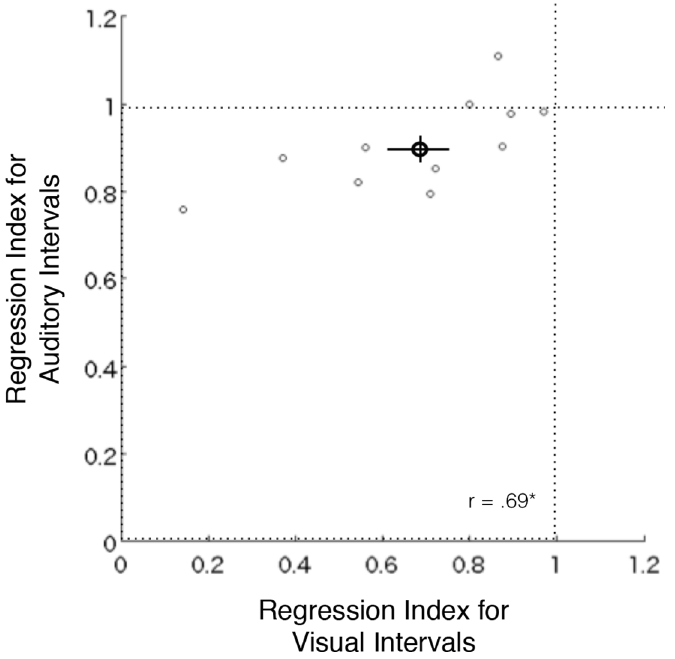
Fig 6. Within-individual correlations of the central tendency across visual and auditory modalities. Regression index represents the slope of the linear regression of the reproduced intervals to the stimulus intervals. Small open circles represent each individual ’ s data. Bold circles and bars represent the mean and the standard error of the mean, respectively. * p < .05.